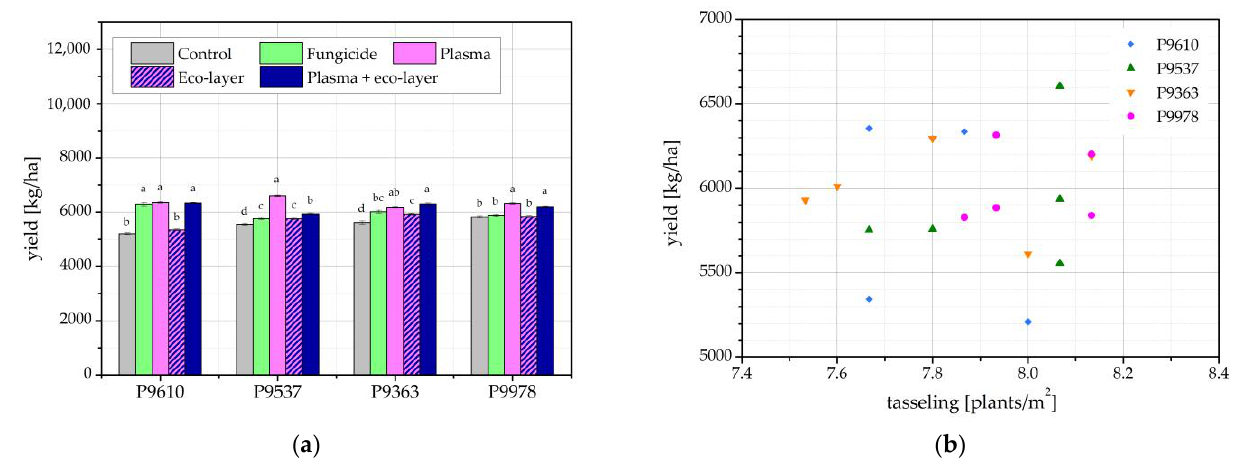
Figure 6. ( a ) Maize yield; and ( b ) correlation between the number of plants at tasseling time and maize yield in the harvest year 2021. The error bars represent standard error. Different lowercase letters above data points represent statistically significant differences ( p < 0.05; post hoc Tukey’s range test) between treatments.